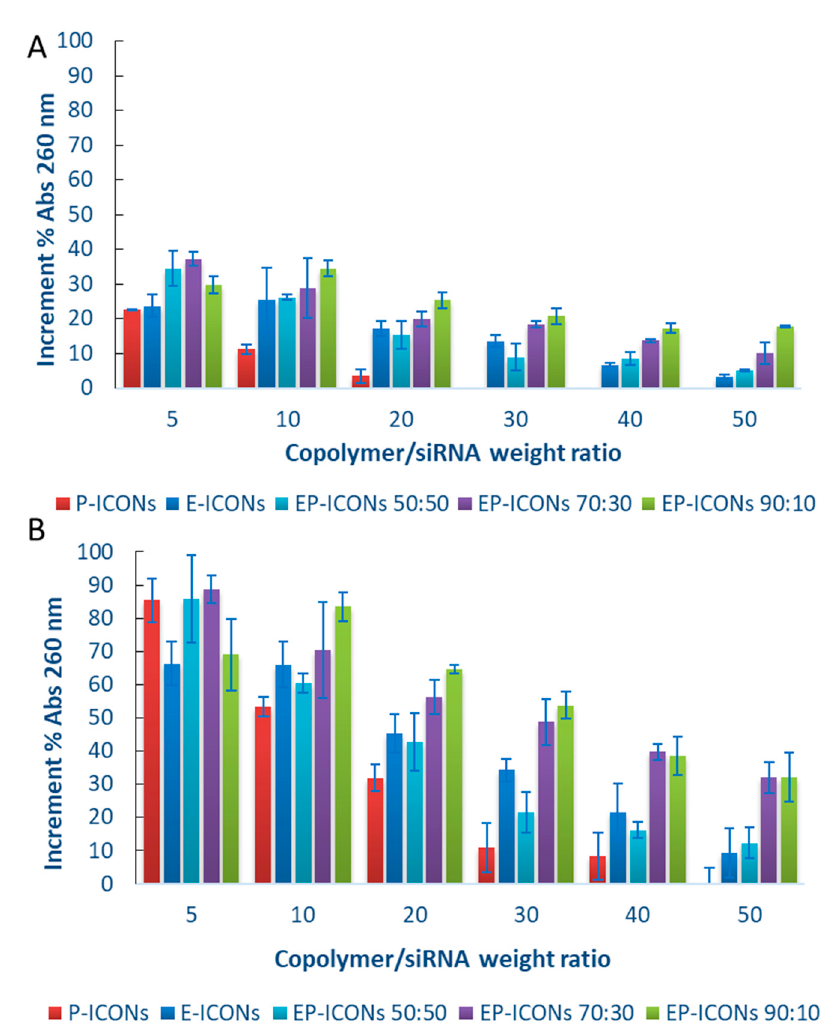
Figure 3. RNase protection assay. ( A ) 4 h, ( B ) 24 h.